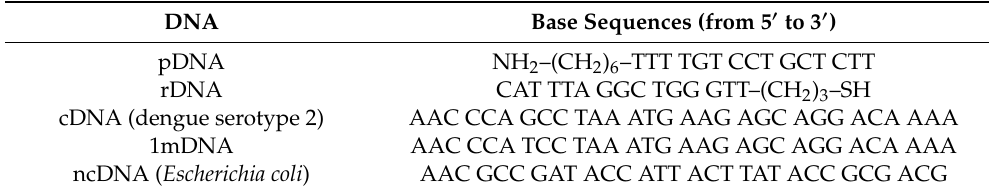
Table 1. Oligonucleotides used in this study. DNA Base Sequences (from 5 (cid:48) to 3 (cid:48)